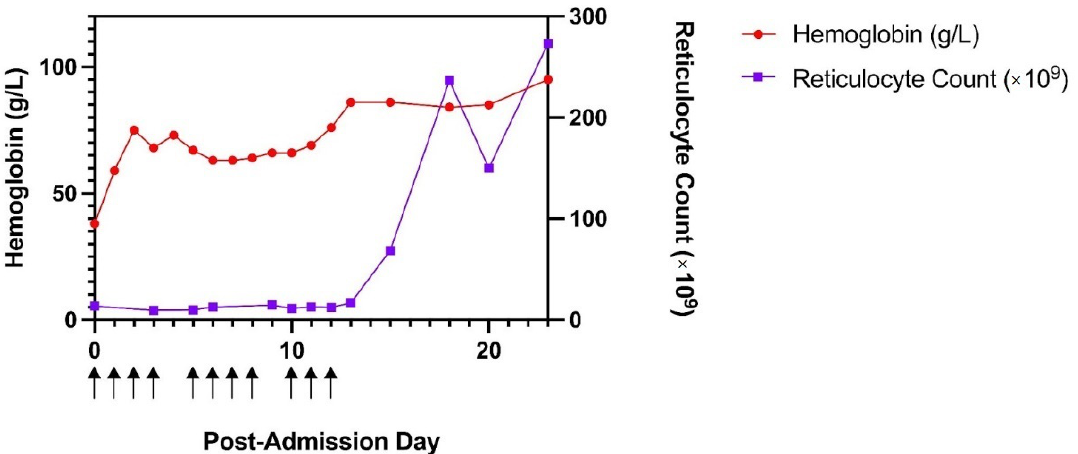
Figure 2. A graph of the patient’s hemoglobin and reticulocyte count over time: The patient’s hemoglobin (g/L) and reticulocyte count ( × 10 9 ) charted over time, as defined by days post-admission to hospital on 10 April 2021. Arrows under the x -axis indicate days on which the patient received one or more blood